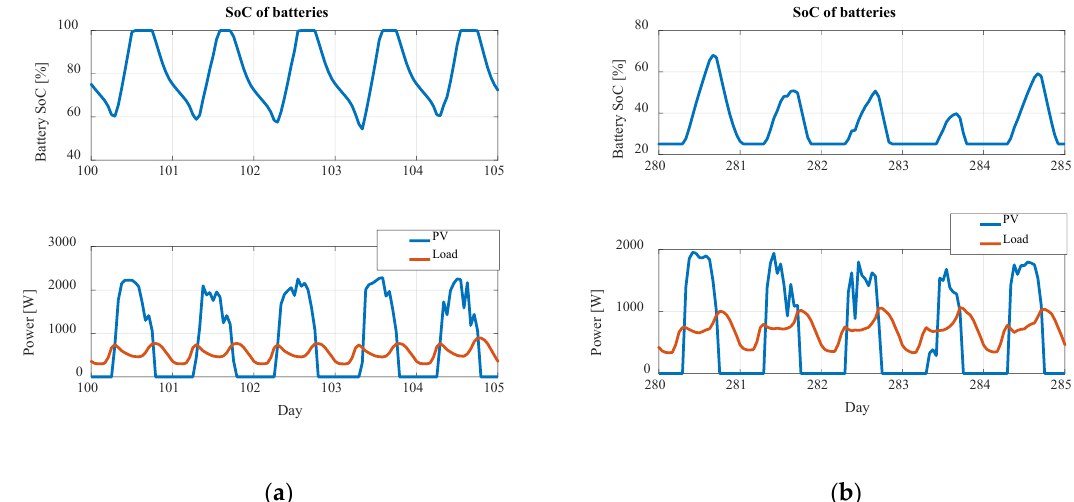
Figure 11. Battery SoC and PV-load power during a five-day period: ( a ) in April, ( b ) in October.